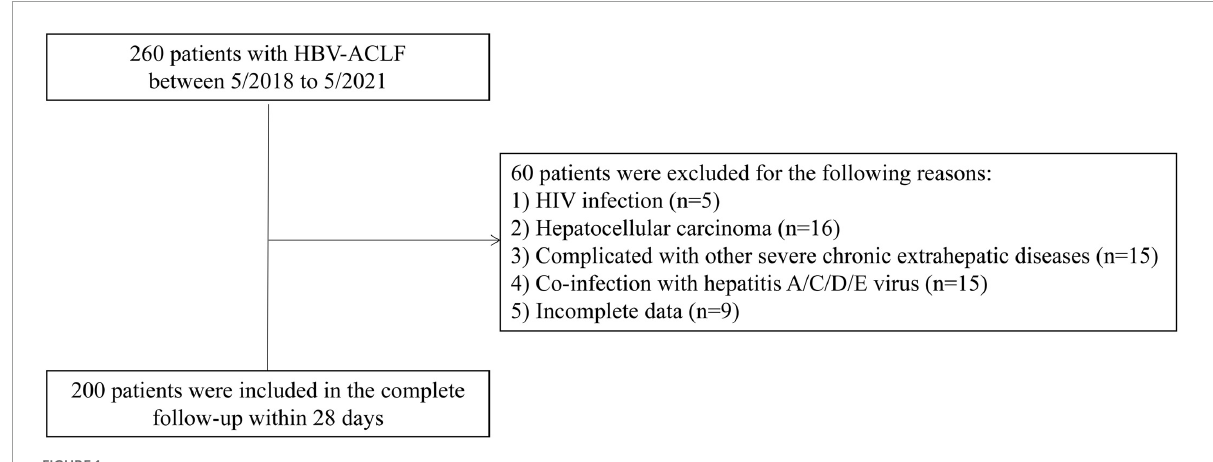
FIGURE1 Flow chart for hepatitis B virus-related acute-on-chronic liver failure (HBV-ACLF) patients in the